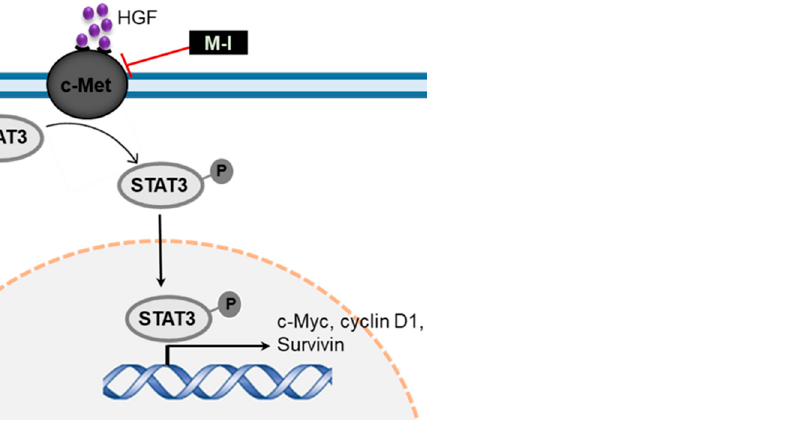
Figure 4. Schematic representation showing mode of action of M-I in inhibition of c-Met signaling. Sharp arrows indicate activation/ induction and blunt arrows indicate inhibition.